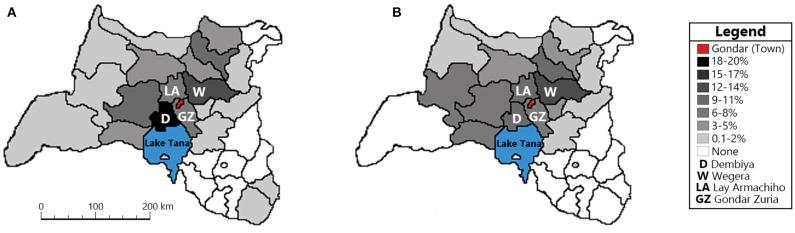
Map indicating the percentage of patients admitted to the University of Gondar College of Medicine and Health Science Comprehensive Specialized Hospital during the dry (A) and wet (B) seasons. Included are the four woredas closest to Gondar: Dembiya (D), Wegera (W), Lay Armachiho (LA), and Gondar Zuria (GZ). Patients admitted from the city of Gondar (37.9%) are not included.